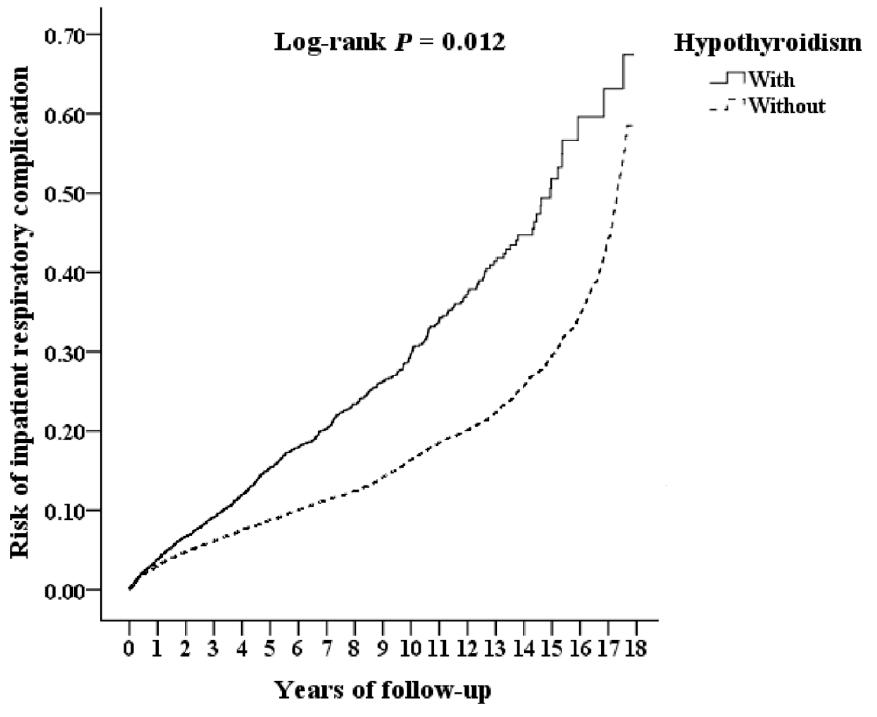
Figure 2. Kaplan–Meier analysis of risk of inpatient respiratory complication among post-CABG patient under aged 65, stratified by diagnosed hypothyroidism and analyzed using a log-rank test. As regards the insured premium range among patients with hypothyroidism who According to the linear regression and Cox regression analysis (Table 3), patients underwent CABG, a significant difference was found between those with a monthly insured salary of more than TWD 35,000 (USD 1250 USD) and those with less than TWD 18,000 (USD 640) ( p < 0.05, p = 0.031). Table 3. Factors of outcomes by using linear regression and Cox